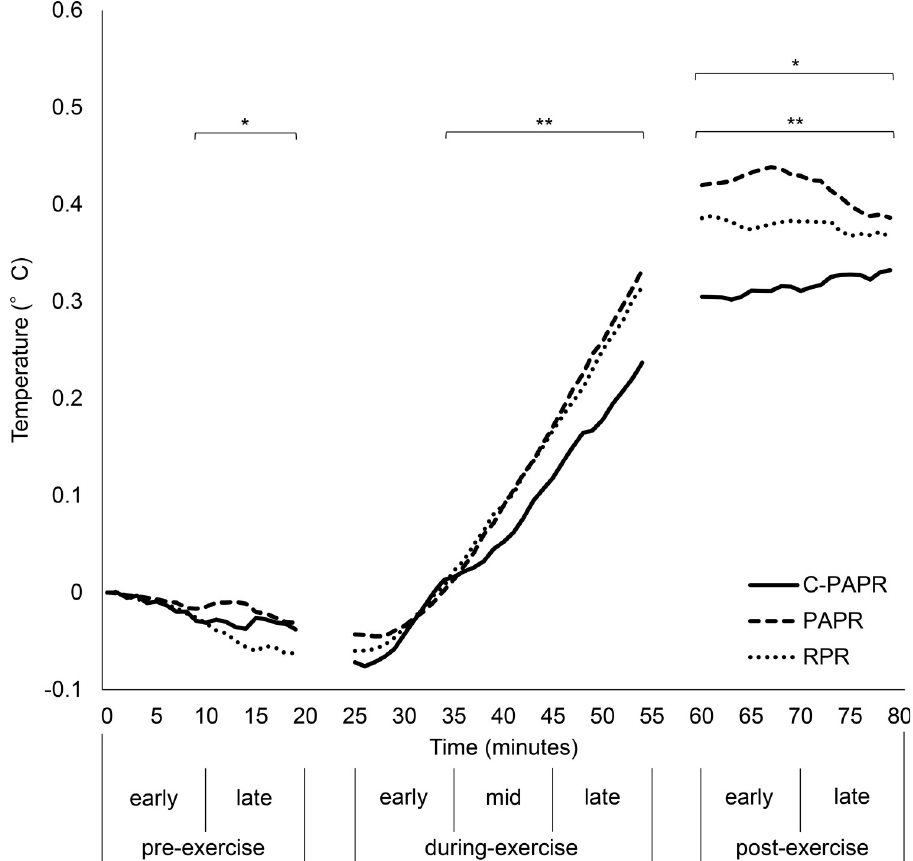
Fig 7. Rectal temperature. The temperature was calculated as the difference between the temperature value at minute 0 and at the minute studied. The measurement values for the time taken to move to the next room were excluded. � Temperature of the RPR was significantly lower than that of PAPR, �� temperature of C-PAPR was significantly lower than that of PAPR and RPR. C-PAPR: powered air-purifying respirator equipped with cooling device; PAPR: powered air-purifying respirator; RPR: replaceable particulate